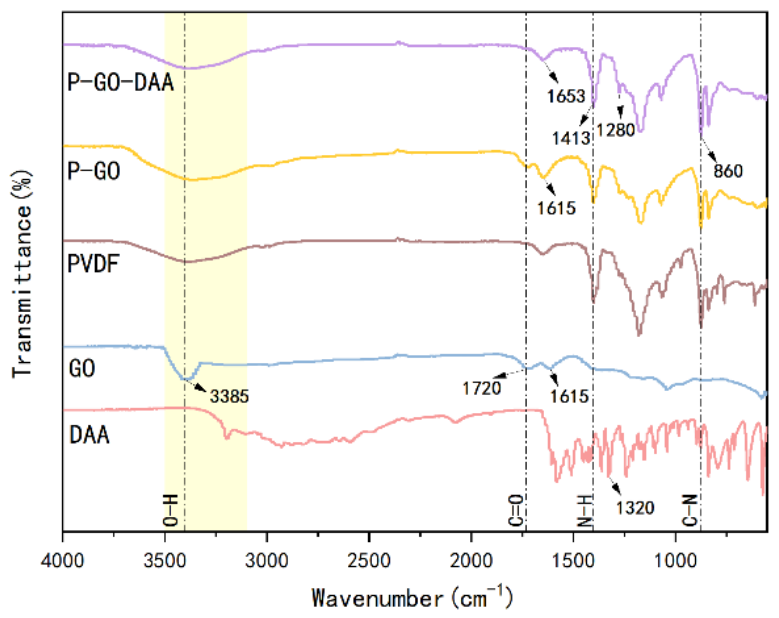
Figure 3. FTIR spectra of DAA, GO, PVDF, P-GO, and P-GO-DAA membranes.